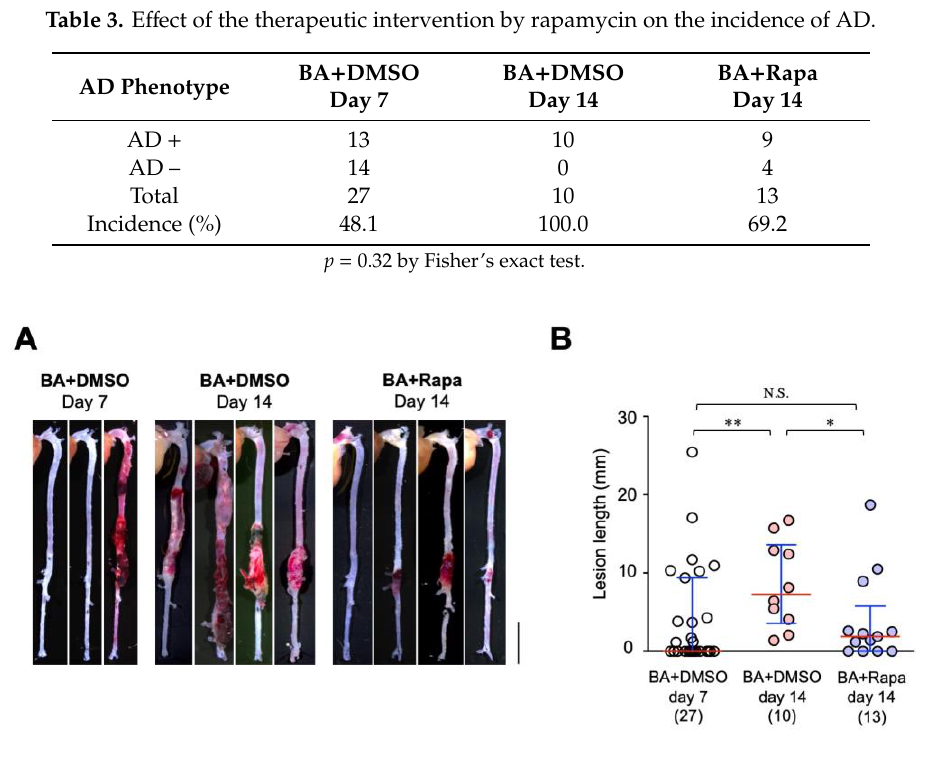
Figure 6. Therapeutic effect of rapamycin on AD. ( A ) Representative macroscopic findings at the indicated periods of BAPN + AngII infusion (BA) with vehicle (DMSO) or rapamycin (Rapa). Scale bar: 5 mm. ( B ) Quantitative analysis of the AD lesion length in the indicated experimental groups. The figures in parentheses indicate the numbers of independent observations. * p < 0.05, ** p < 0.01, *** p < 0.001.